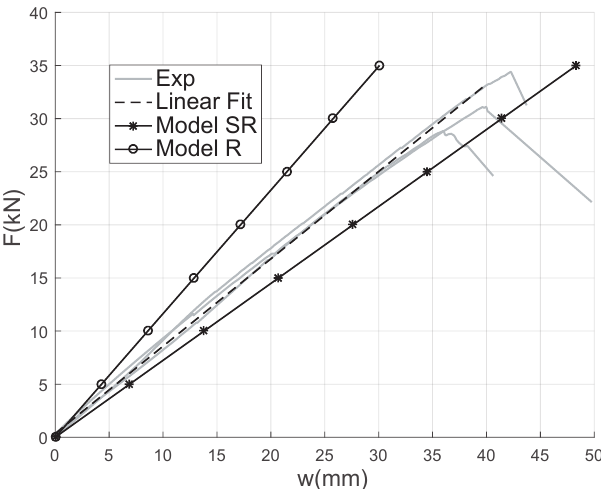
Figure 7. Deflection-load curves at mid-span for tests and calculation models. SR, semi-rigid; R,